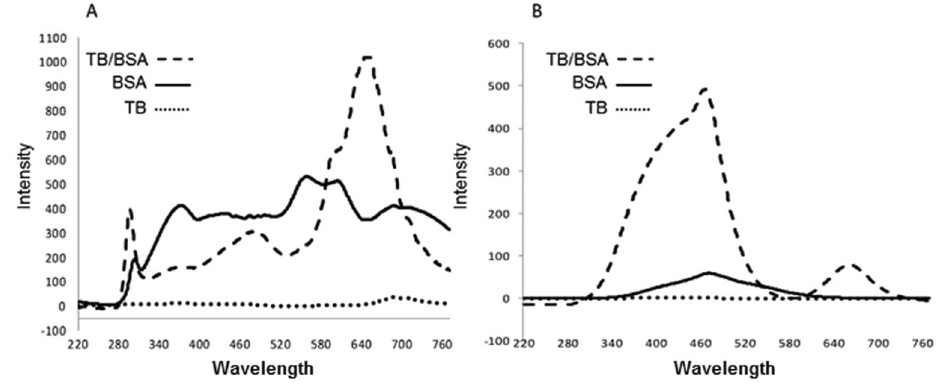
Figure 1. Spectrofluorophotometry analysis of the excitation ( A ) and emission ( B ) spectra of the solutions containing 0.02% (w/v) trypan blue (TB, dotted line), bovine serum albumin (BSA, solid line) at 10% (w/v), and TB-BSA (dashed line)